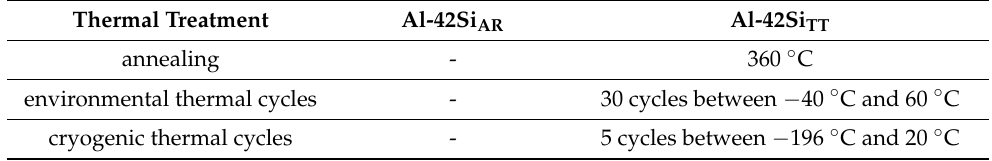
Table 1. Thermal histories of as-received (Al-42Si AR ) and thermally treated (Al-42Si TT ) Al-42Si. Thermal Treatment Al-42Si AR Al-42Si TT annealing environmental thermal cycles - cryogenic thermal cycles - 5 cycles between − 196 ◦ C and 20 ◦